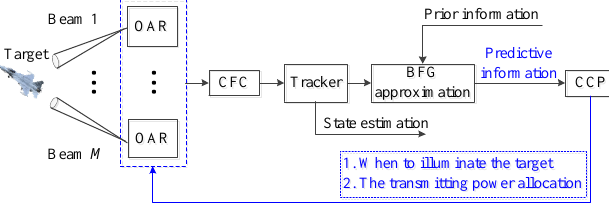
Figure 2. Block diagram of resource management for maneuvering target tracking (MTT).